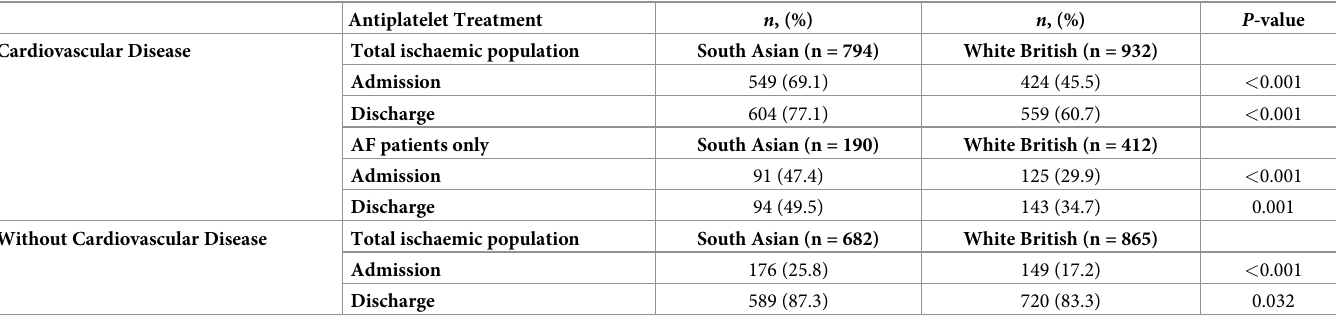
Table 3. Antiplatelet treatment at admission and discharge stratified by ethnicity and cardiovascular